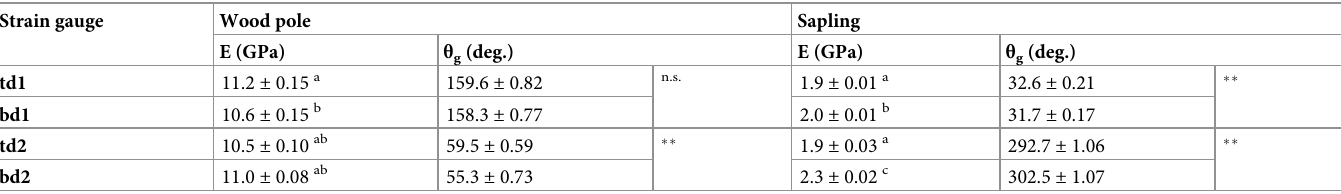
there were significant differences of approxi- g, and h : 99.9–103.0˚ for the t b